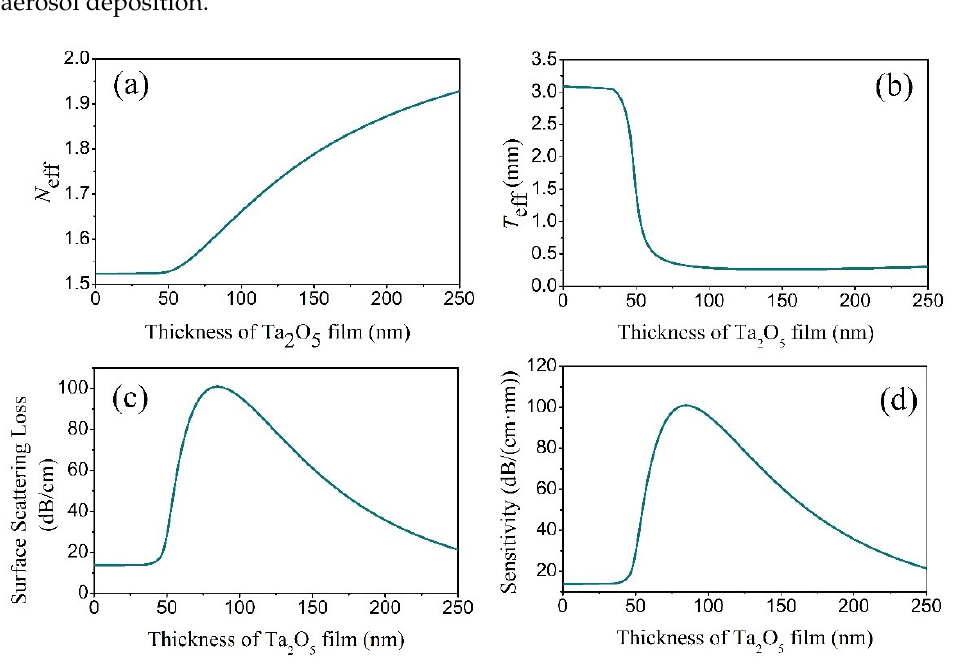
Figure 4. Simulation results for the TE 0 mode in the COWG with a tapered film of Ta 2 O 5 : ( a ) N eff , ( b ) T eff , ( c ) α S , and ( d ) sensitivity versus the film thickness.